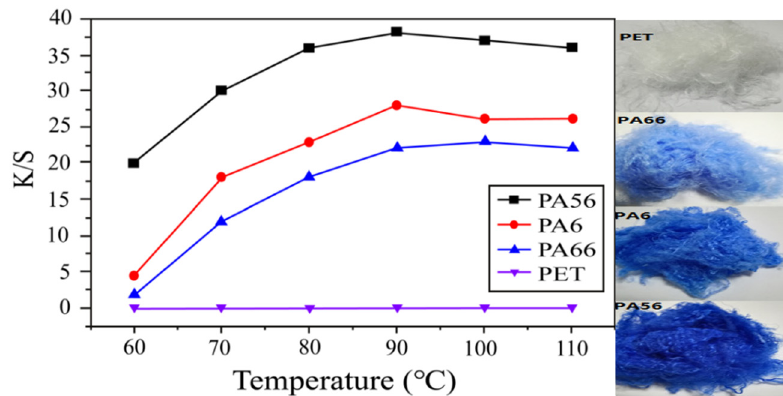
Figure 1: Dyeing property of acid dyes for several kinds of fi bers ( 44 dtex/36 f FDY ) .